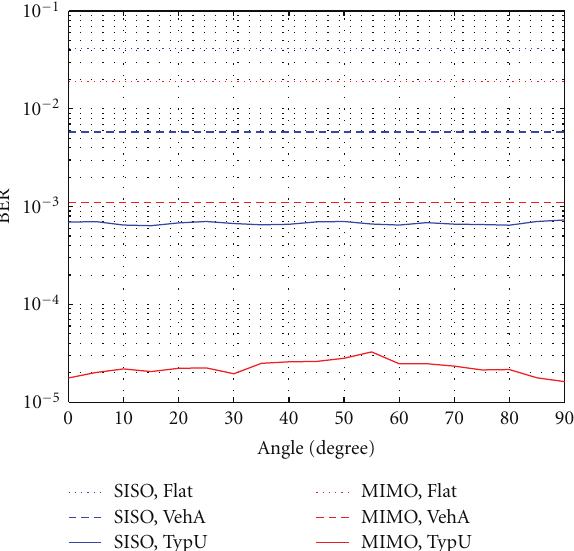
Figure 5: BER performance of turbo-coded transmission with CRM2 for di ff erent propagation channels.